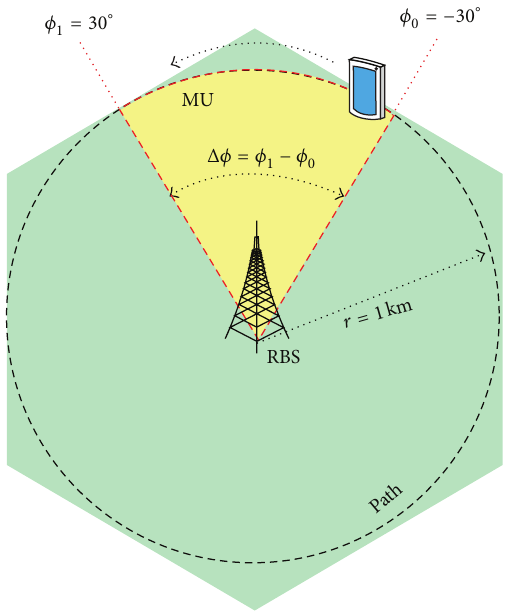
Figure 1: Mobile user scenario. The user moves with a uniform speed with constant radial distance from the